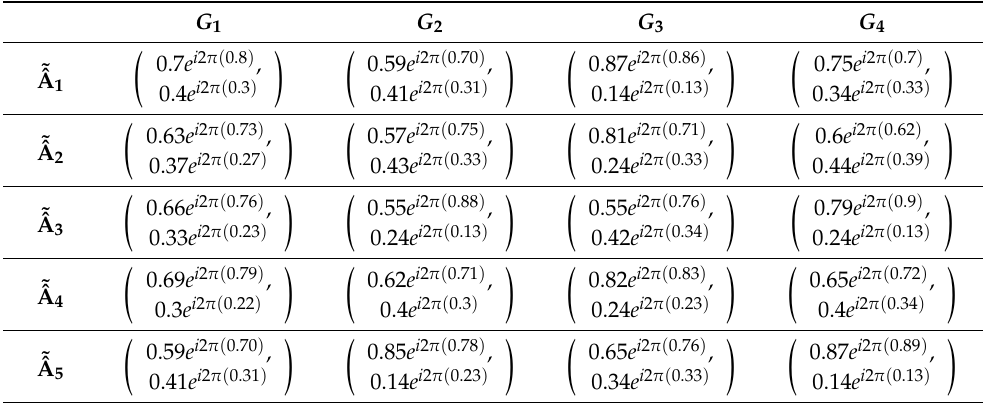
Table 7. Decision matrix for Example